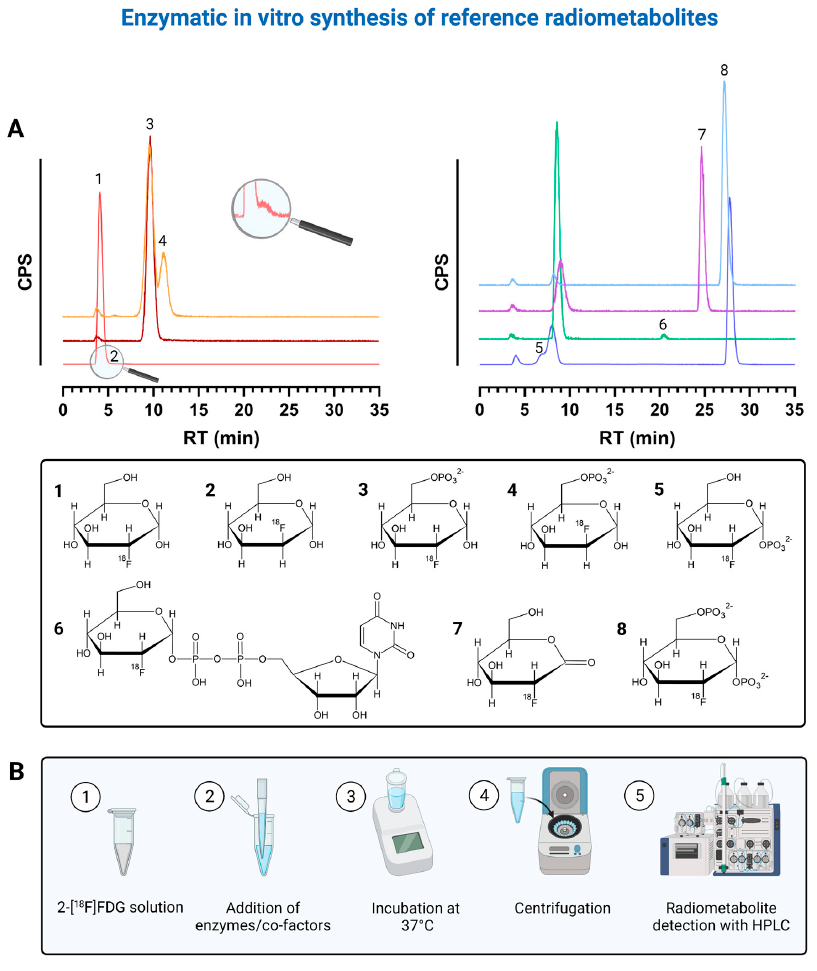
Figure 1. ( A ) shows representative chromatograms of the reference radiometabolites that were prepared via enzymatic in vitro synthesis and corresponding chemical structures. Each color represents the chromatogram of a different reference compound. 1 = 2 ‐ [ 18 F]FDG, 2 = 2 ‐ [ 18 F]FDM, 3 = 2 ‐ [ 18 F]FDG ‐ 6 ‐ P, 4 = 2 ‐ [ 18 F]FDM ‐ 6 ‐ P, 5 = 2 ‐ [ 18 F]FDG ‐ 1 ‐ P, 6 = UDP ‐ 2 ‐ [ 18 F]FDG, 7 = 2 ‐ [ 18 F]FD ‐ PGL, 8 = 2 ‐ [ 18 F]FDG ‐ 1,6 ‐ P 2 . ( B ) shows the corresponding workflow of enzymatic in vitro synthesis of reference radiometabolites. Created with BioRender.com (accessed on 4 September 2021) based on HPLC raw data and graphs from Prism 7.03